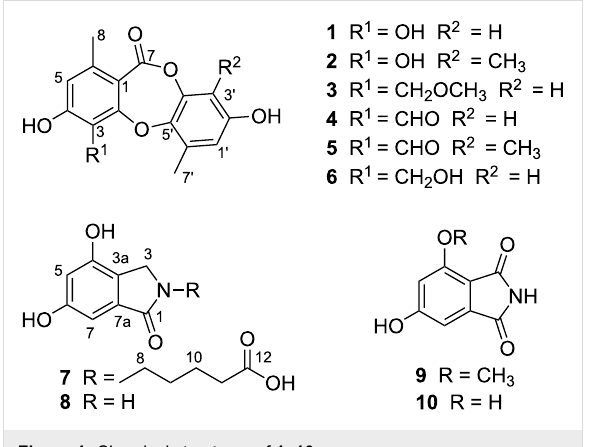
Figure 1: Chemical structures of 1 – 10 .